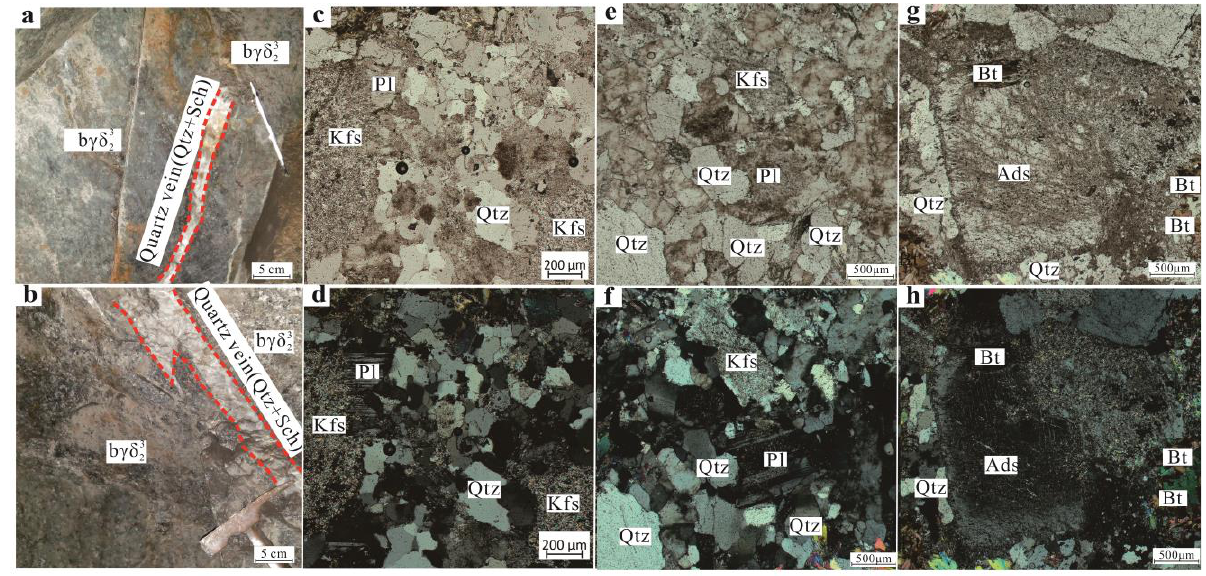
Figure 2. Field ( a , b ) and microscopic photos ( c – h ) of Jiningian granodiorite in the Dahutang deposit. bγδ2: Jiningian granodiorite; Sch: scheelite; Qtz: quartz; Pl: plagioclase; Kfs: K-feldspar; Bt: biotite; Ads: andesine.